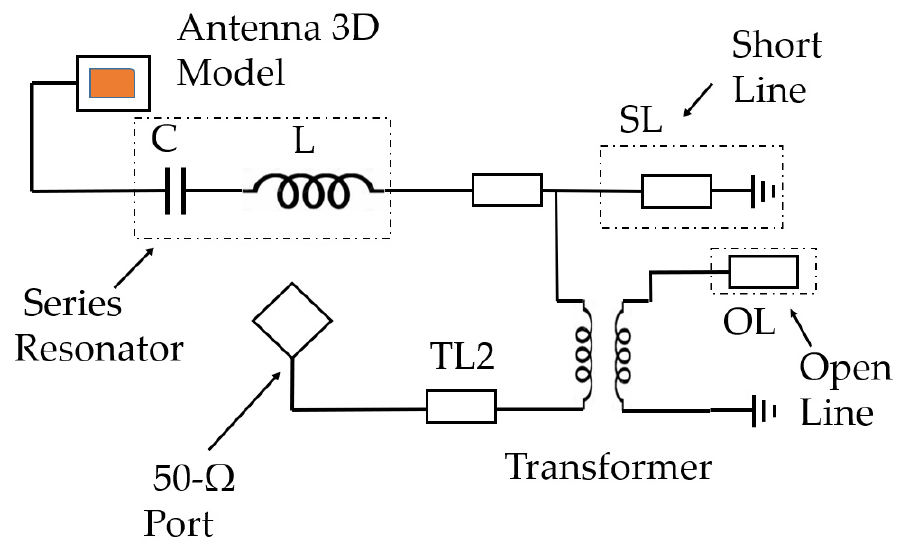
Figure 6. Circuit theory model of matching circuit.